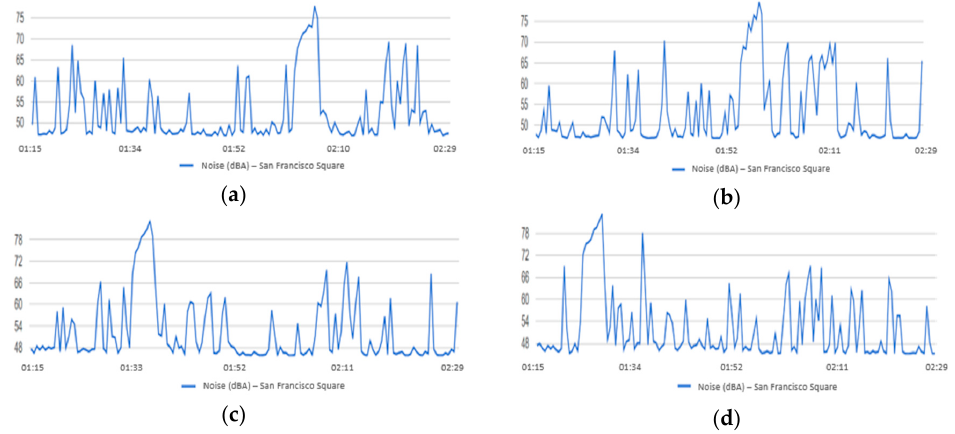
Figure A1. The temporal evolution of the noise in San Francisco Square for the period of 01:15–02:30